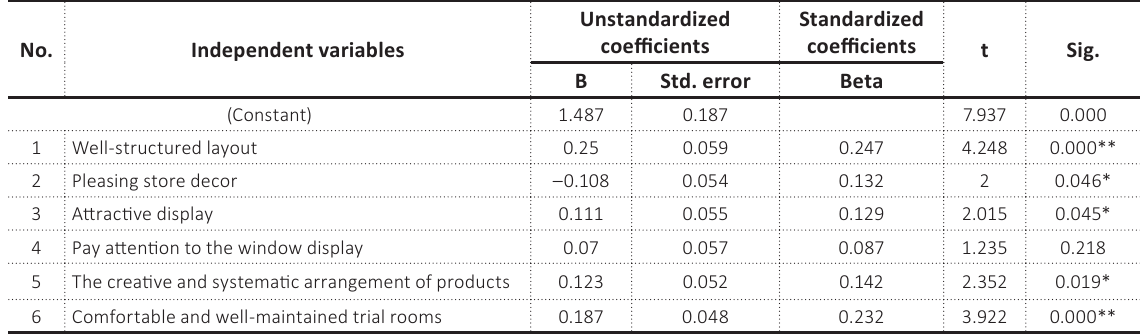
Table 11. Regression analysis of the impact of store layout on impulse buying behavior No.